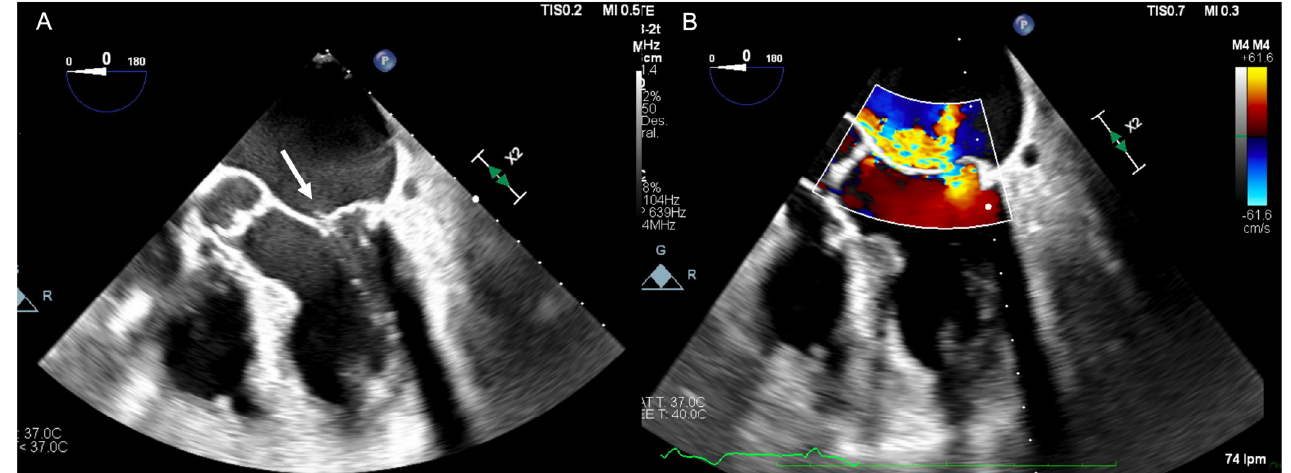
Figure 1. ( A ) Transoesophageal echocardiographic four chamber mid oesophageal view illustrating a flail posterior mitral valve leaflet with ruptured chordae (white arrow). ( B ) Colour Doppler demonstrating an eccentric jet of severe mitral regurgitation.